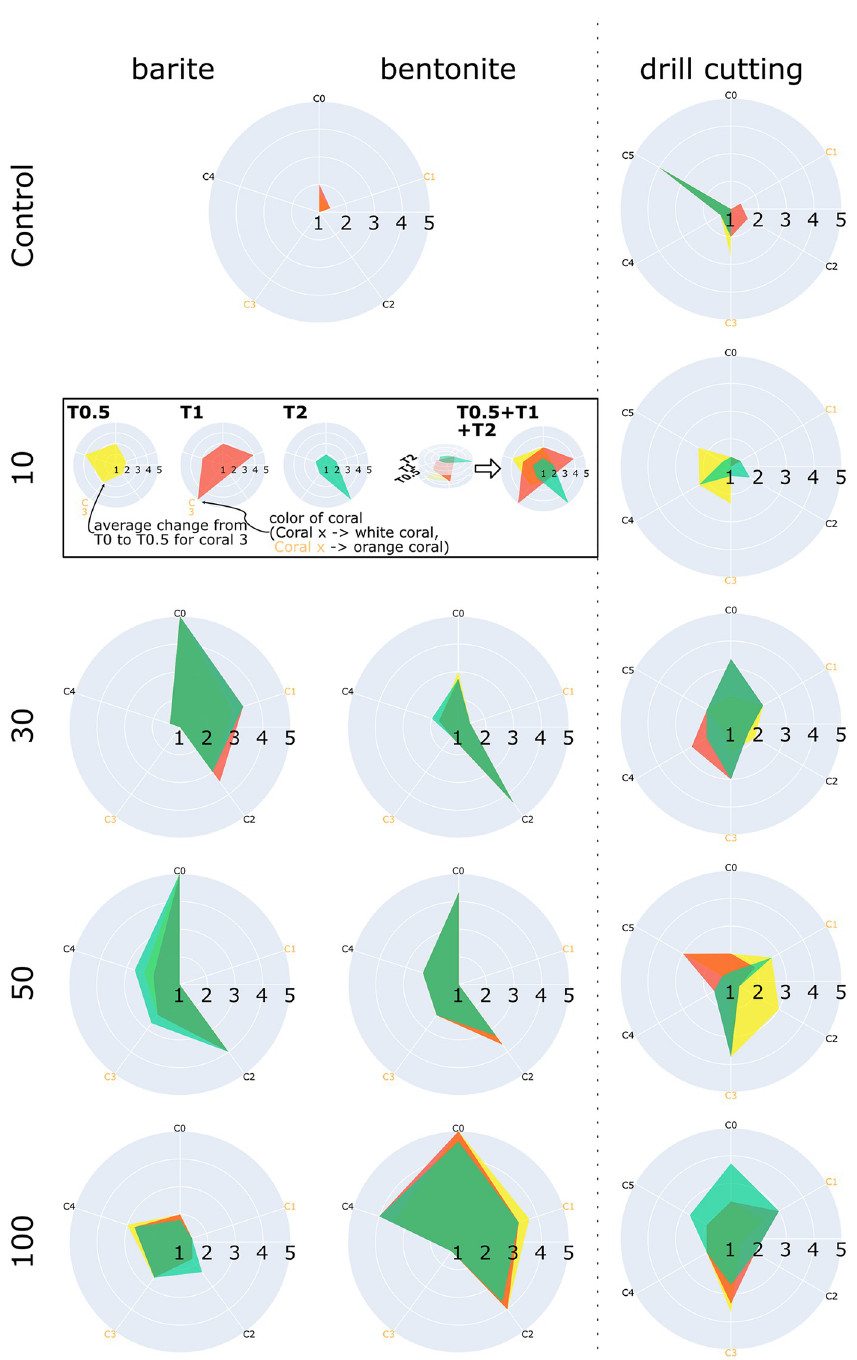
Fig 4. Subjective rating results of the changes from initial time point T0 to final time point T2 of the bentonite, barite and DC experiment after six weeks. All values represent the average over all subjective ratings. Ratings range from 1 (no change) to 5 (strong change). Analogues to the color scale of the Hyperspectral Viewer, yellow is T0.5 (directly after exposure), red is T1 (two weeks after exposure) and green is T2 (six weeks after exposure). The titles of the subgraphs are the concentrations in mg � L − 1 of the exposure depicted as the row